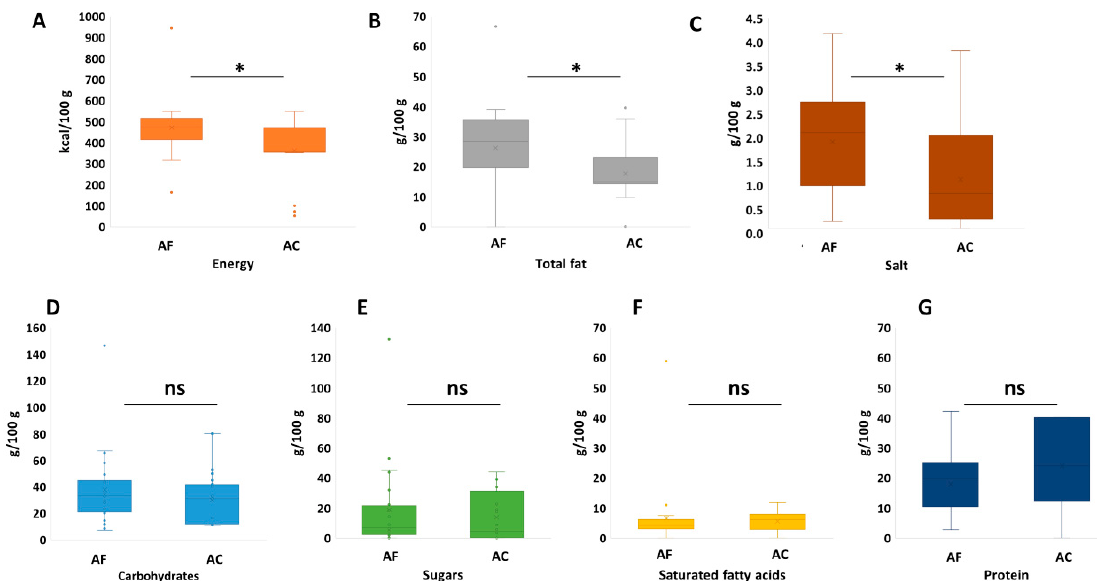
Figure 1. Nutritional profile of snacks formulated with algae ( n = 24) vs. algae-free snacks ( n = 24). ( A ): energy (kcal/100 g), ( B ): total fat (g/100 g), ( C ): salt (g/100 g), ( D ): carbohydrate (g/100 g), ( E ): sugars (g/100 g), ( F ): saturates (g/100 g), and ( G ): protein (g/100 g). AF: algae-free and AC: algae-containing; statistical significance based on Kolmogorov–Smirnov test (*: p < 0.05, ns: non-significant ( p > 0.05)); the box-plot legend: the box is limited by the lower (Q1 = 25th) and upper (Q3 = 75th) quartile; the median is the horizontal line dividing the box; Whiskers above and below the box indicate the